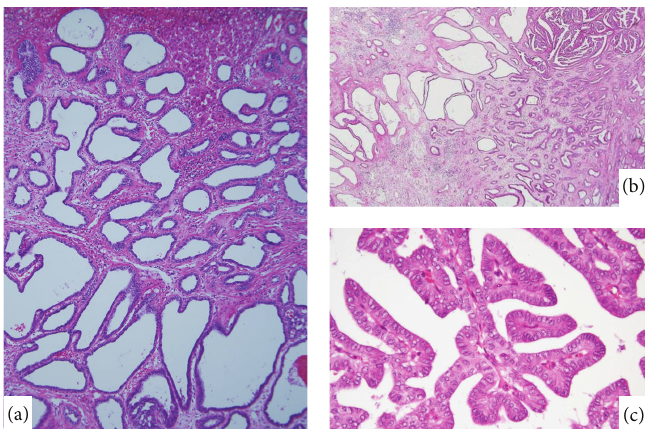
Figure 2: Biliary adenofibroma. (a) Tubular structures with fibrous stroma characterize this tumor. Focally, micropapillary features are found in the left lower corner. (b) Papillary features with complicated structures suggest an imminent malignant transformation.